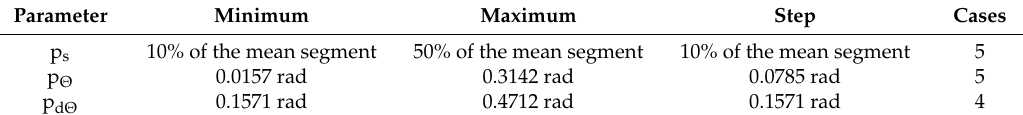
Table 4. Values of parameters used in this application.